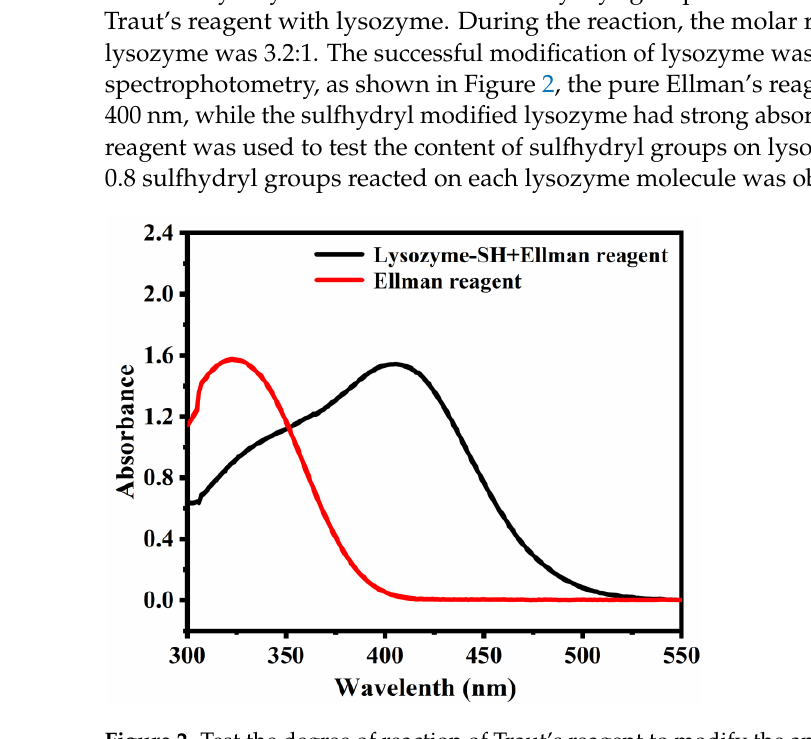
Figure 2. Test the degree of reaction of Traut’s reagent to modify the amino group of lysozymes by Ellman’s reagent .